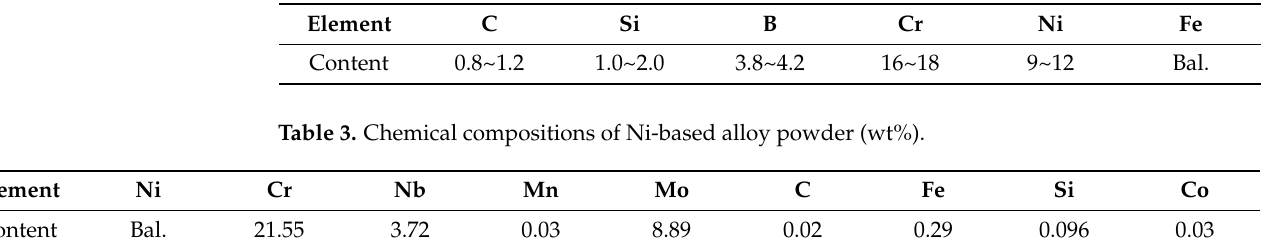
Table 2. Chemical compositions of Fe-based alloy powder (wt%).